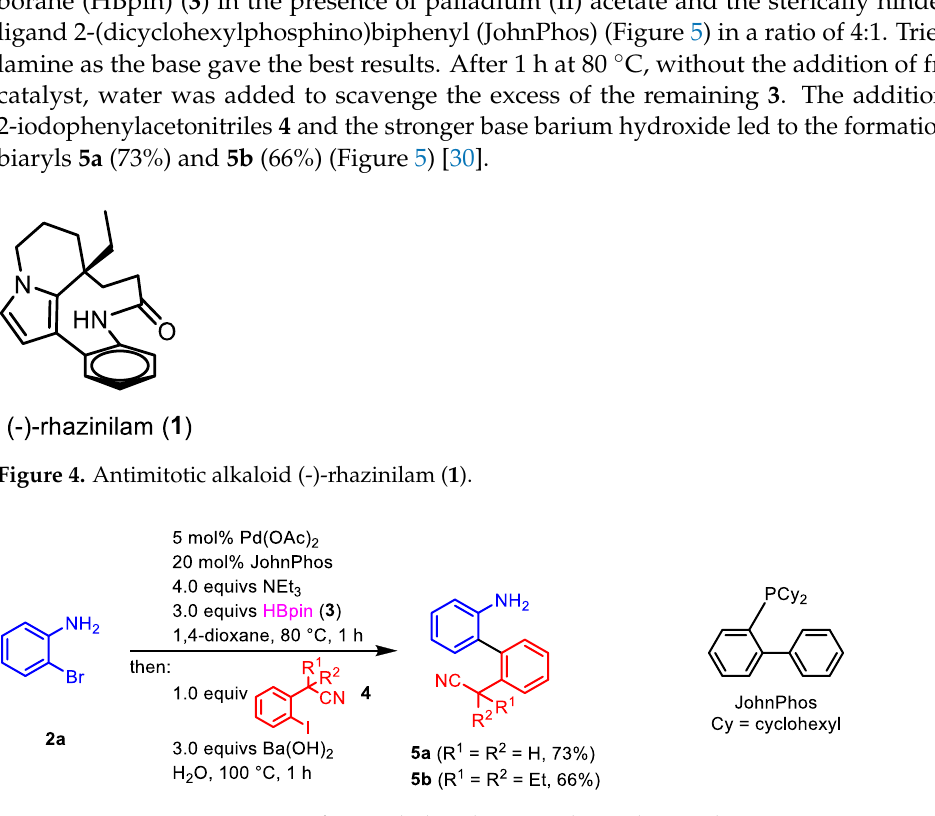
Figure 7. First employment of heterocycles in the one-pot MBSC sequence [35]. Additionally, Baudoin could establish a general consideration for the order of the borylation and the cross-coupling compound. It was found that the Masuda borylation step gives higher conversions with electron-rich substrates bearing electron-donating groups (EDG). It is expected that electron-rich aryl halides and electron-deficient organo- boron compounds favor the σ -bond metathesis [26]. The resulting electron-rich boronate intermediates are more reactive in the transmetalation step of the Suzuki coupling. Fortu- nately, Suzuki coupling works best with electron-poor aryl halides with electron-with- drawing groups (EWG) (Figure 8). Figure 8. Order of the electronics of borylation and cross- coupling components in Baudoin’s one - pot MBSC sequence [35]. 2.2. Queiroz’s One-Pot MBSC Sequence with Benzothiophene Substrates